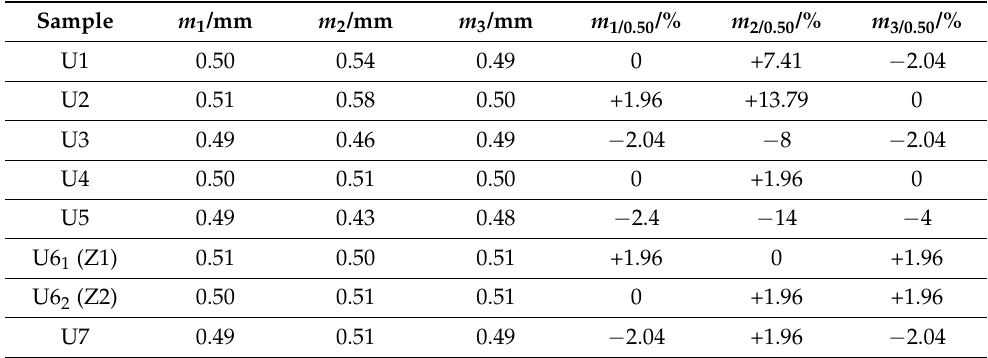
Table 7. Results of measuring dimensions on samples U1, U2, U3, U4, U5, U6 1 (Z1), U6 2 (Z2), U7.